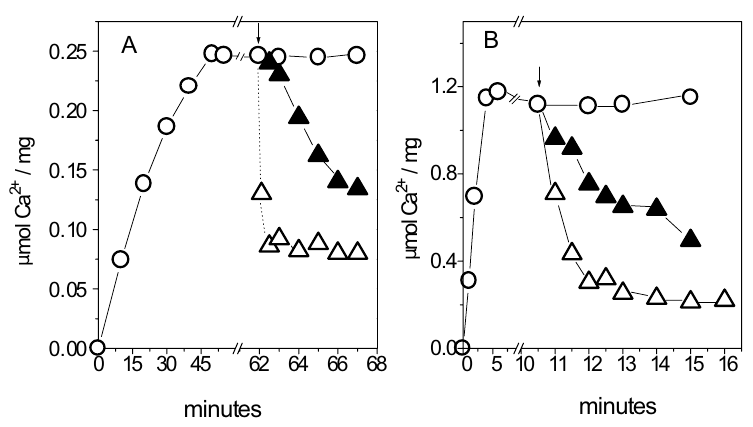
Fig. 7 – Ca 2 + release after the addition of PAF. muscle (B) vesicles. The assay medium composition was 50 mM MOPS/Tris pH 7.0, 2 mM MgCl 2 , 10 mM P i , 40 µ M CaCl 2 , 100 mM KCl and 3 mMATP. The reaction was started by the addition of either platelets (A) or muscle (B) vesicles at 35 ◦ C. ( ❍ ) control without additions. The arrow indicates the addition of either 6 µ M PAF ( (cid:5) ) or 6 µ M PAF plus 1 M thapsigargin ( (cid:5)